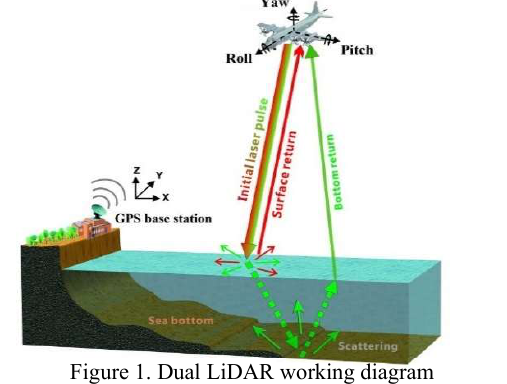
Figure 1. Dual LiDAR working